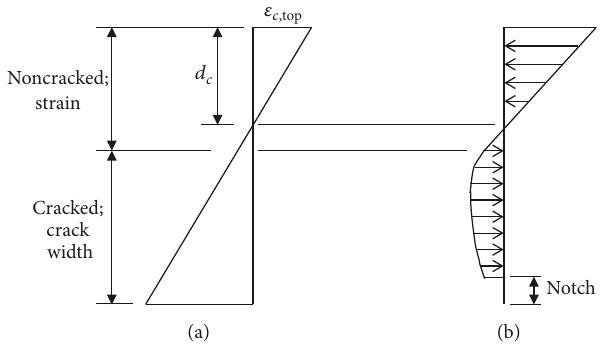
Figure 3: Crack width, strain, and stress distribution through the section with a notch; (a) section compatibility and (b) stress